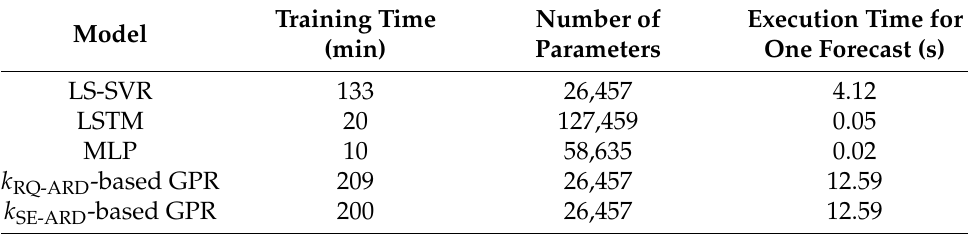
Table 5. Comparison of models’ computation time and complexity (number of